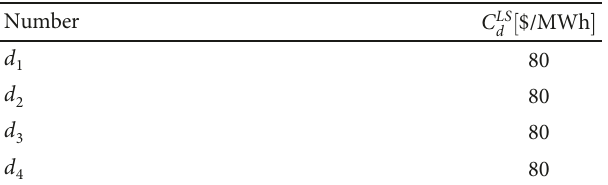
Table 9: Costs of nonsupplied demand.